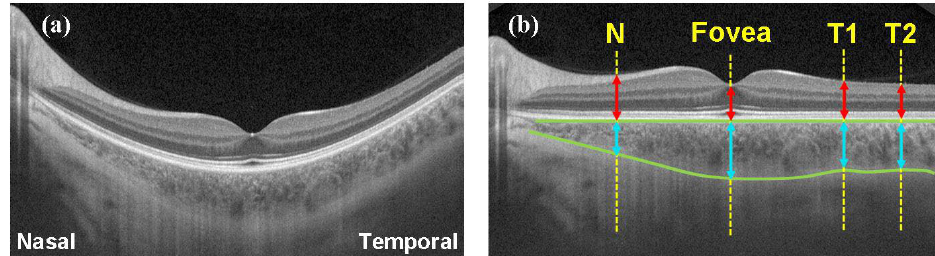
Figure 2. Example of OCT fundus images (B-scans) of the retina of one of the participants before ( a ) and after ( b ) the flattening operation. The horizontal distribution of the RPE is easily observed in panel ( b ). The four locations of interest where the neural retina (red) and choroid (blue) thickness values were: N, nasal; Fovea; T1, temporal 1; and T2, temporal 2. See text for further details.